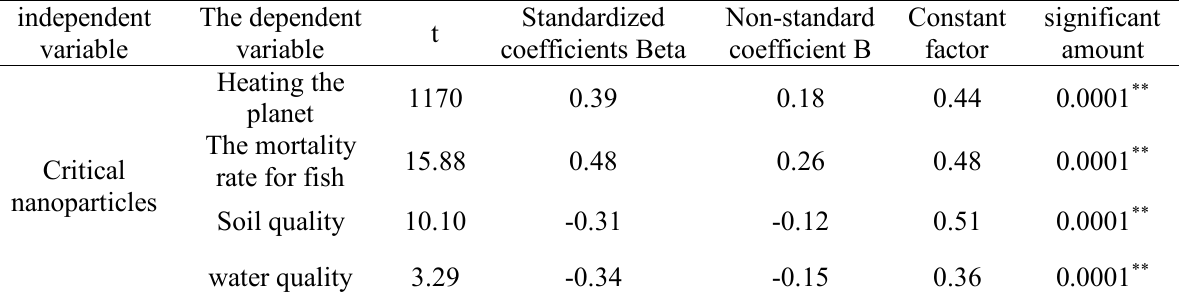
Table 6. Coefficients determine the effect of heating nanoparticles crisis on the planet, the rate of mortality of aquatic, soil quality and water quality